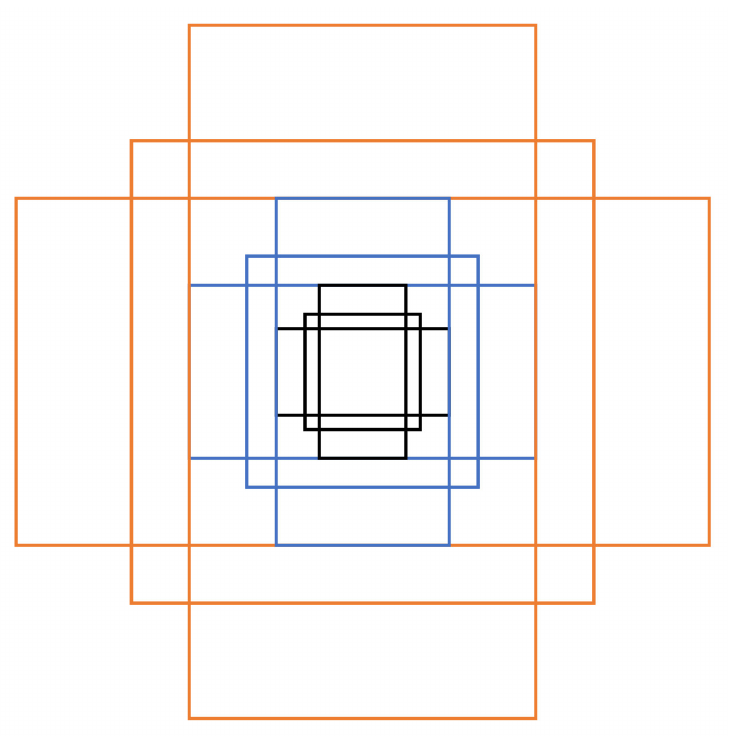
Figure 4. Anchor box with the default